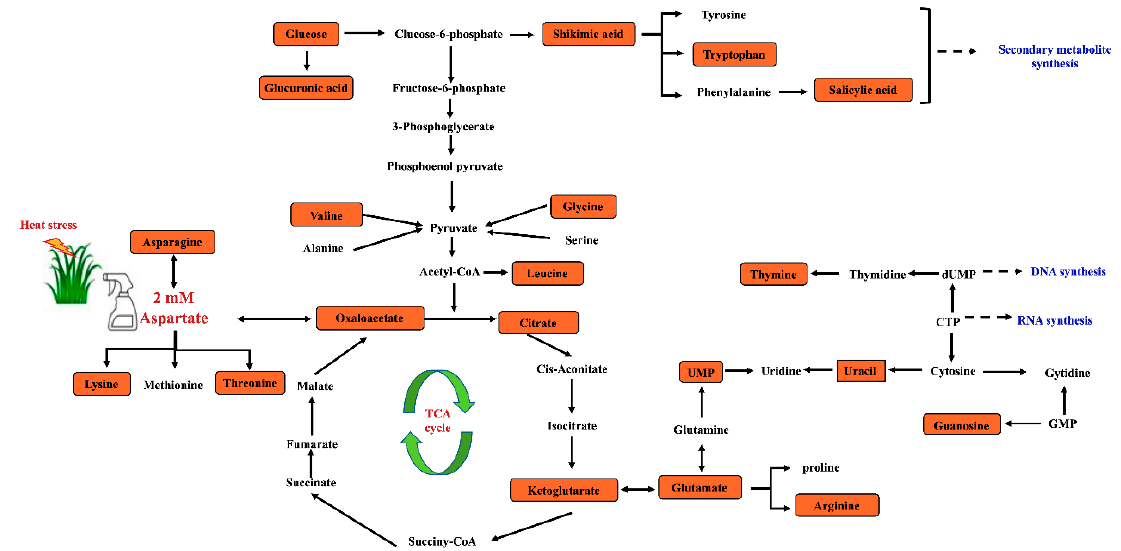
Figure 9. Schematic diagram illustrating metabolic pathways and specific metabolites regulated by aspartate in perennial ryegrass exposed to heat stress in relation to Asp-enhanced heat tolerance. The orange boxes represent significantly up-regulated metabolites by aspartate treatment.